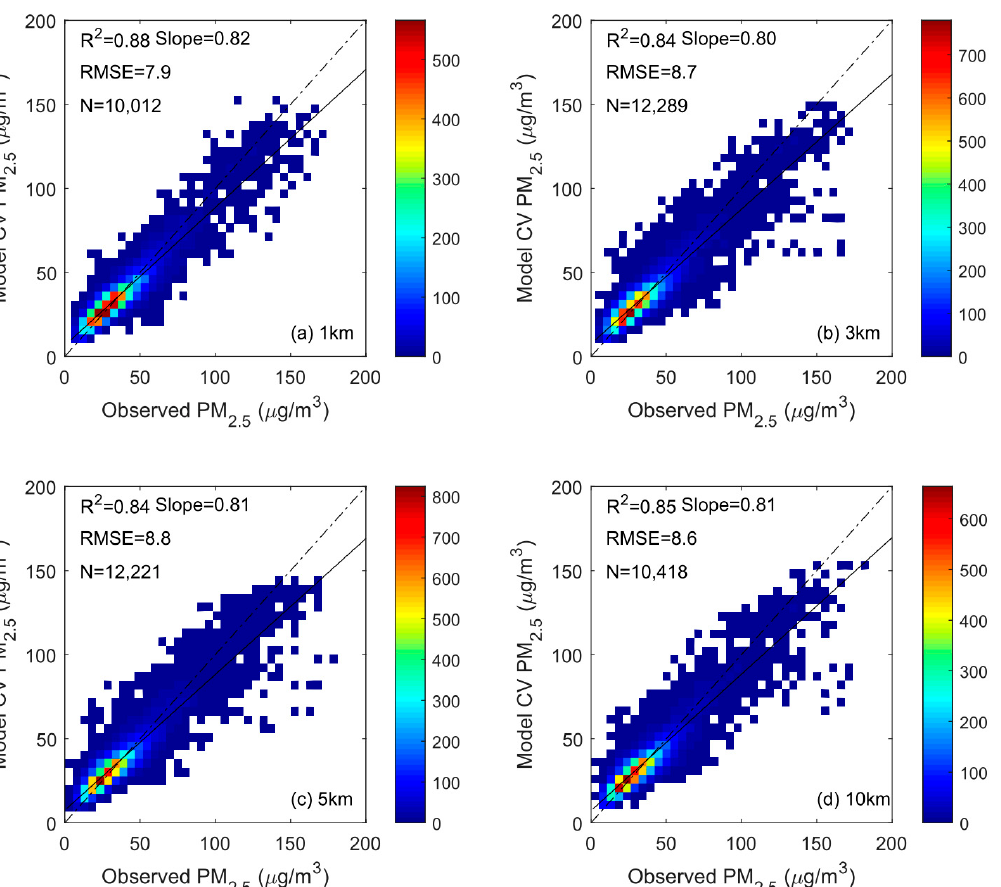
Figure 6. Scatter plots of 10-fold cross validation (CV) results for the Random Forest (RF) model at the resolutions of ( a ) 1, ( b ) 3, ( c ) 5 and ( d ) 10 km. The color bar represents the counts of samples. R 2 , RMSE and N are the coefficient of determination, root-mean-square error and number of samples, respectively. The dashed line stands for the 1:1 line.